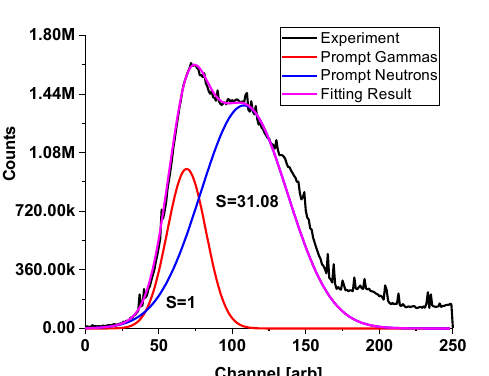
Fig. 9. Radiation from the reactor burst with decomposition into the neutron (partially moderated/resonance) and gamma plus fast neutrons, escaped the moderator, represented by Gaussians. S indicates relative area under the Gaussians.